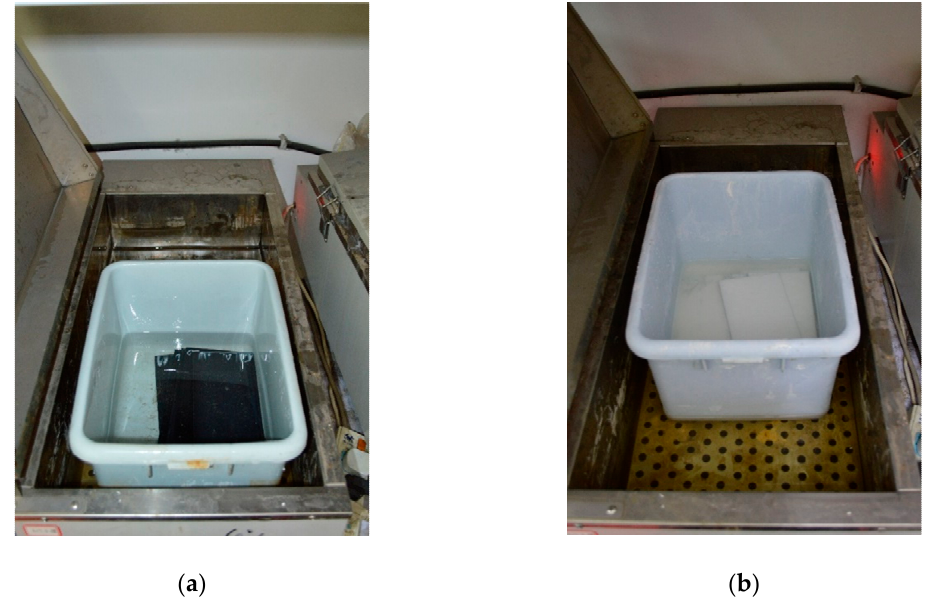
Figure 3. Specimens immersed in: ( a ) Water; ( b ) Alkaline solution. Table 1. Components of alkaline solution.